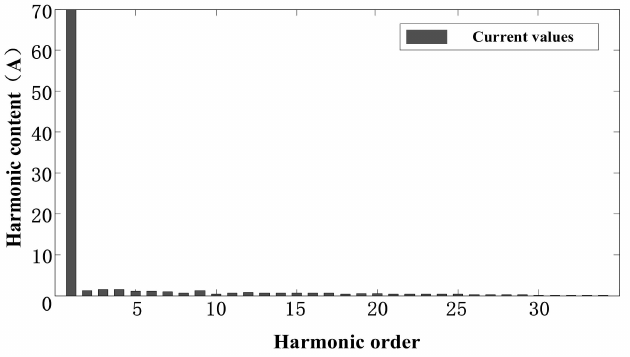
Figure 9. The low-order current harmonics of GSC in sub-synchronous